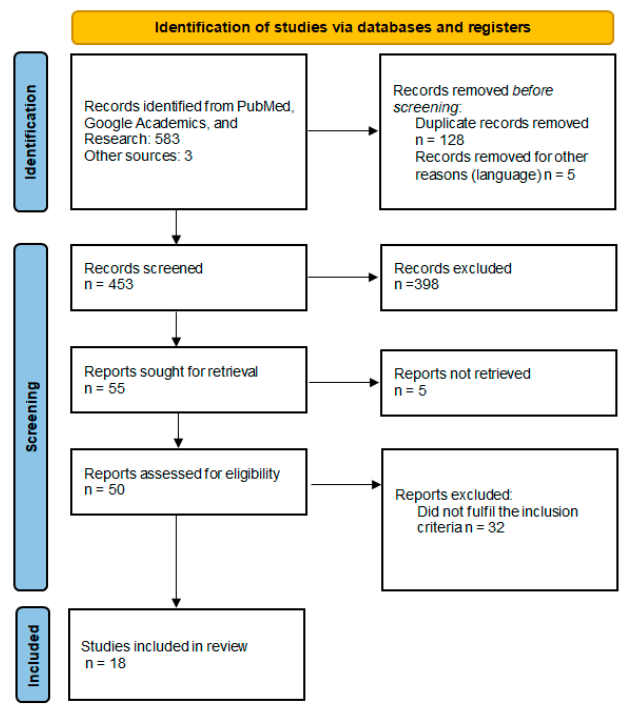
Figure 1. Details of the literature review—PRISMA diagram.